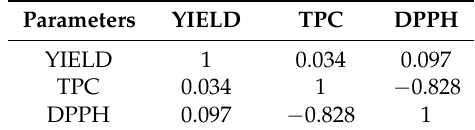
Table 3. The correlation analysis between parameters and T. sericea phenolic acid extracts. Parameters